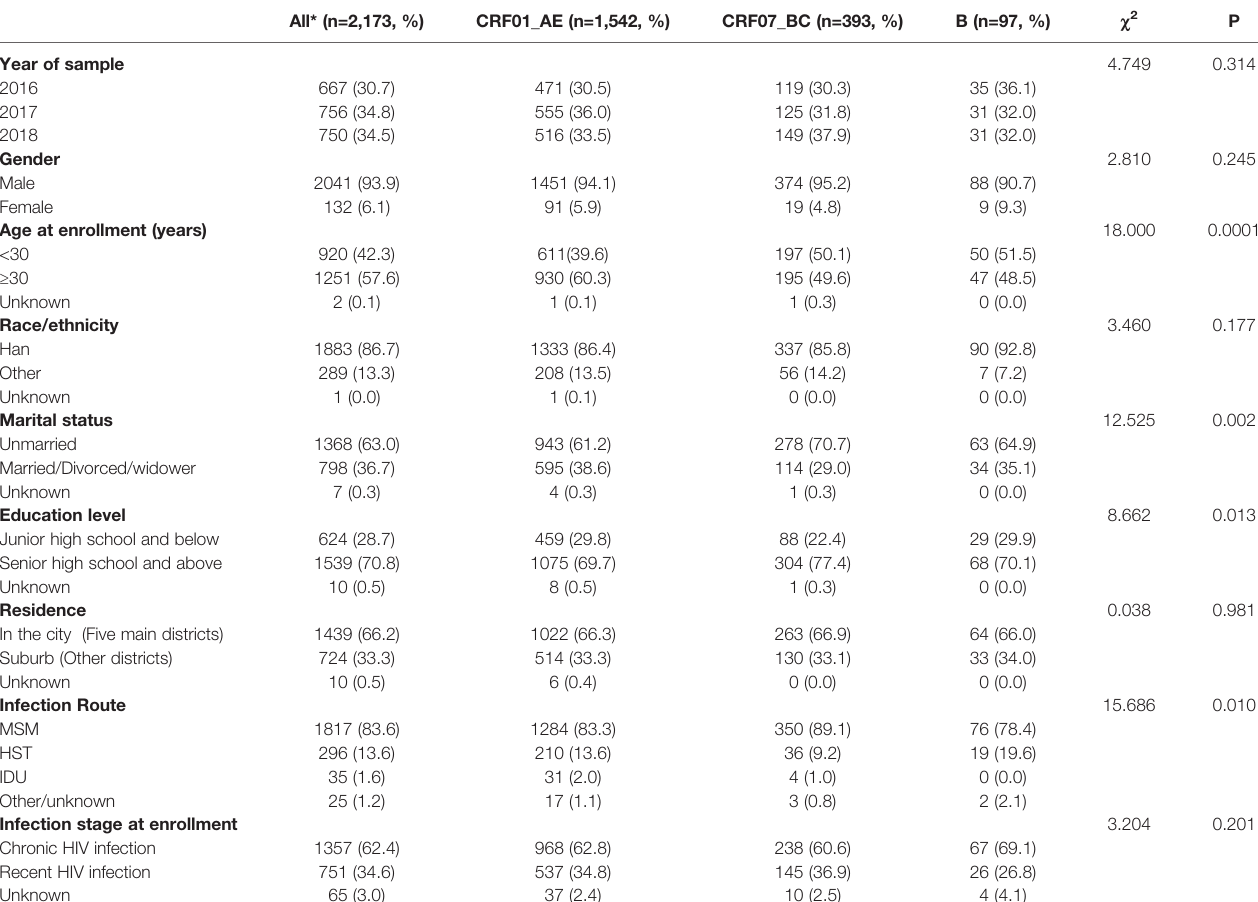
TABLE 1 | Population characteristics in Shenyang based on different